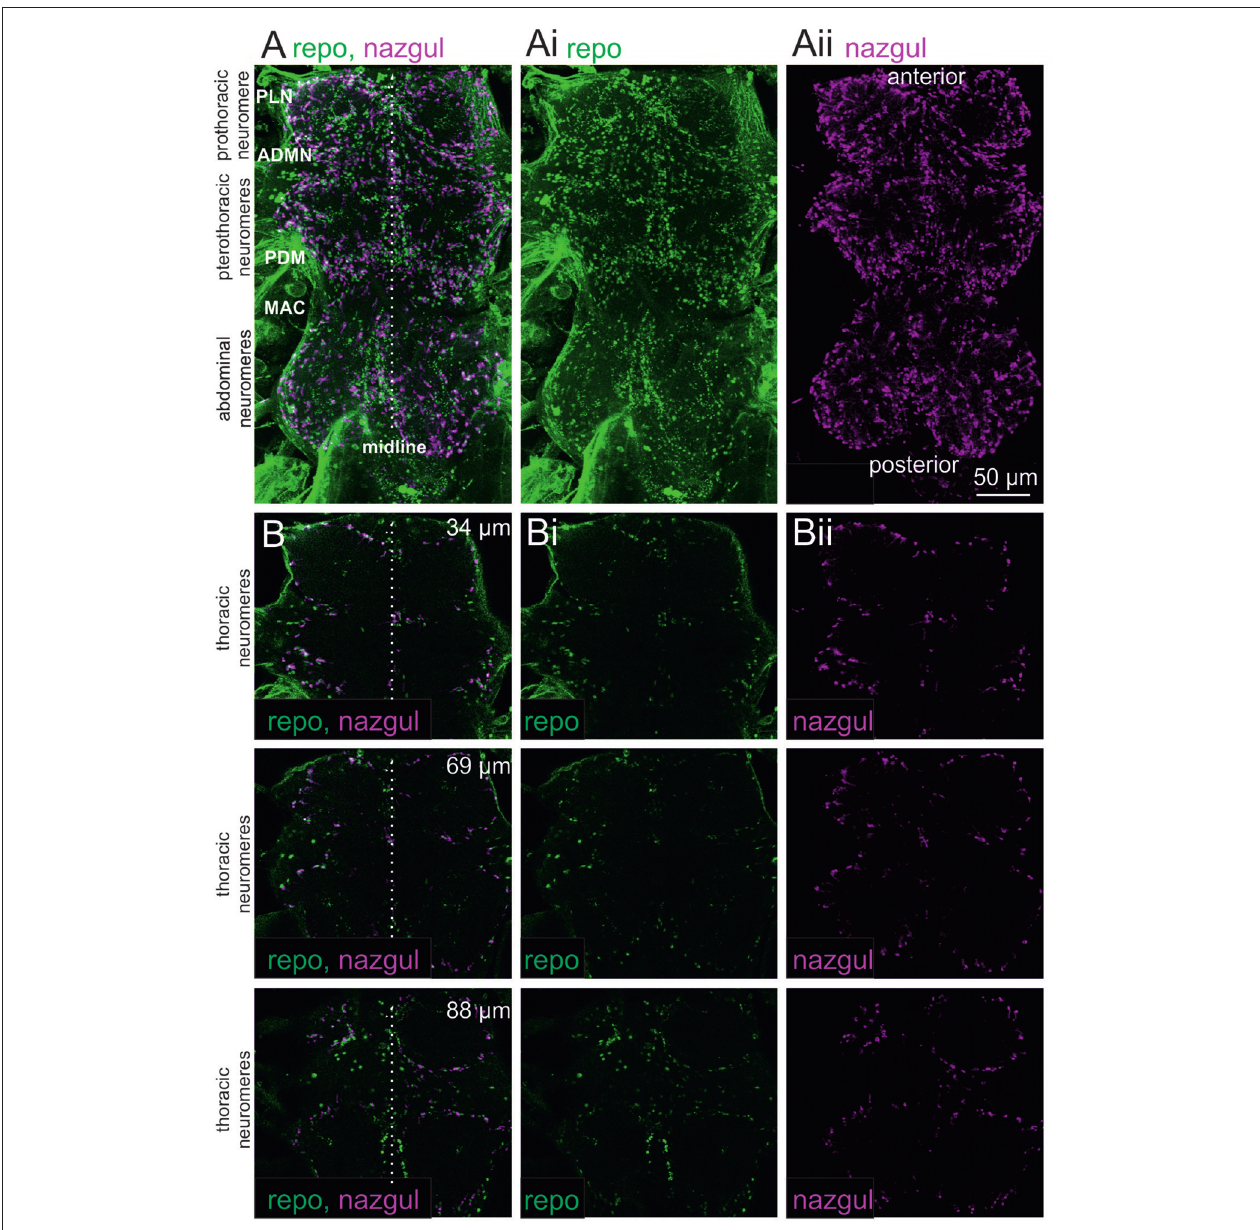
FIGURE 1 | Nazgul (Naz) localizes in similar patterns as Repo positive glial cells in the ventral nerve cord (VNC). (A) Maximum projection views of a representative confocal image stack taken from double immunolabeling of Naz (magenta) and Repo (green) in the VNC. The locations of the prothoracic, pterothoracic (meso- and metathoracic) and abdominal neuromeres are indicated. The midline is indicated by a dotted white line and prominent nerves are labeled (PLN, prothoracic leg nerve; ADMN, anterior dorsal mesothoracic nerve; PDM, posterior dorsal mesothoracic nerve; MAC, mesothoracic accessory nerve). The individual labels for Repo and Naz are shown in (Ai,Aii) . (B) Single optical sections of Naz (magenta) and Repo (green) label at 34 µ m (upper row), 69 µ m (middle row) and 88 µ m (lower row) imaging depth show that Naz and Repo positive cells localize to the borders of the motor neuropils. The individual labels for Repo and Naz are shown in (Bi,Bii) .